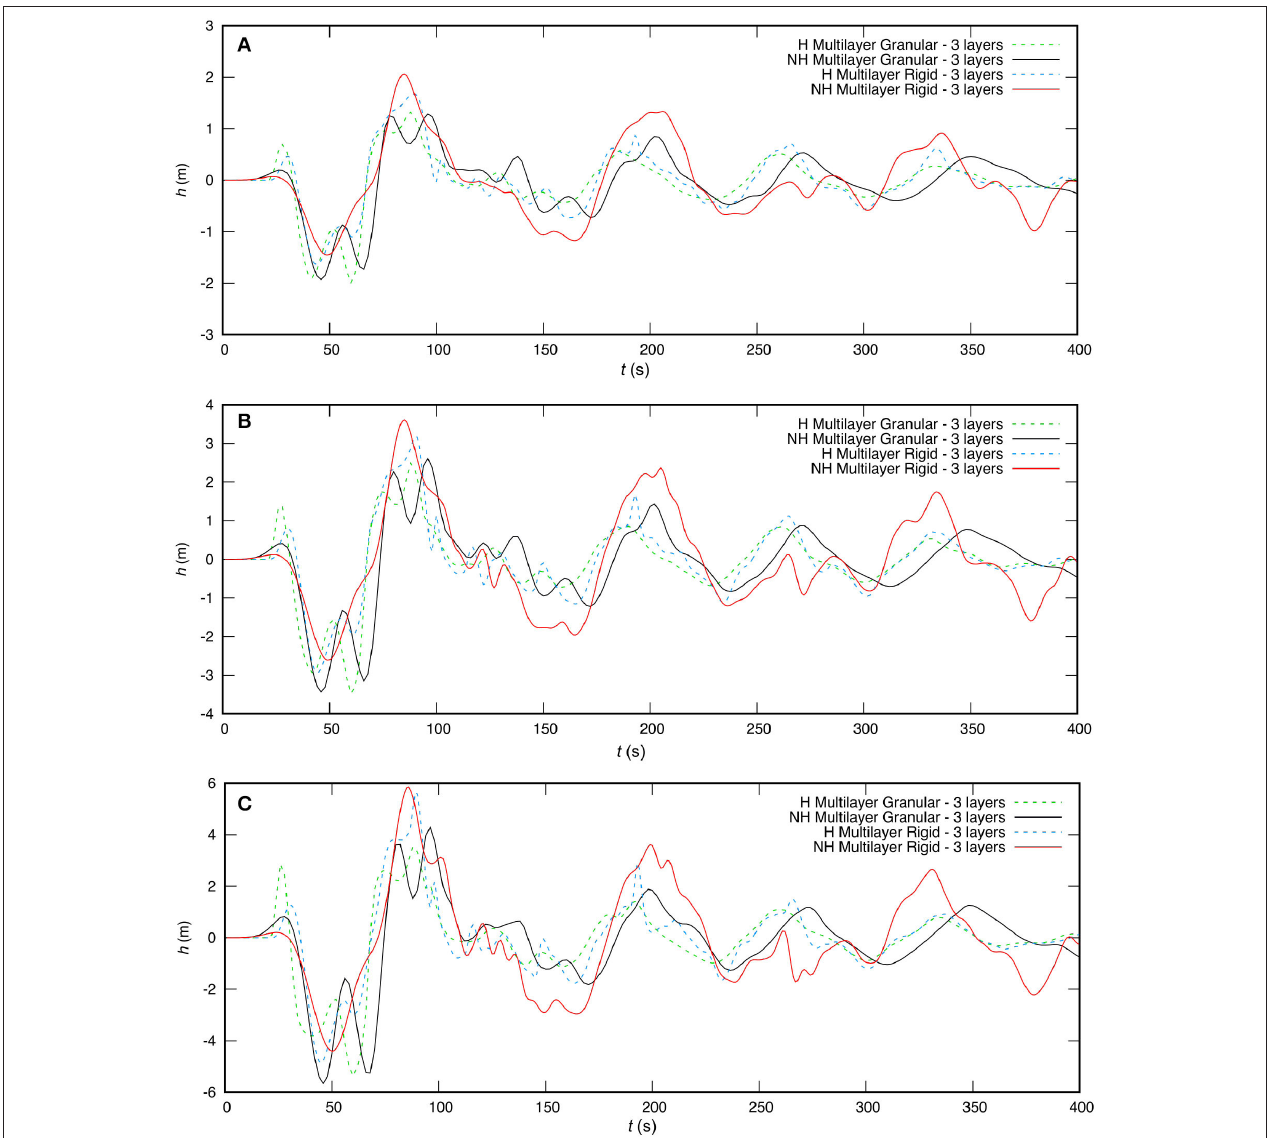
FIGURE 5 | Wave forms at gauge 1 simulated with a hydrostatic and non-hydrostatic Multilayer-HySEA model with either a rigid or a granular landslide, and three vertical layers. The three subplots are for different landslide volumes: (A) V = 7.1 × 10 6 m 3 , (B) V = 11.8 × 10 6 m 3 , and (C) V = 17.6 × 10 6 m 3